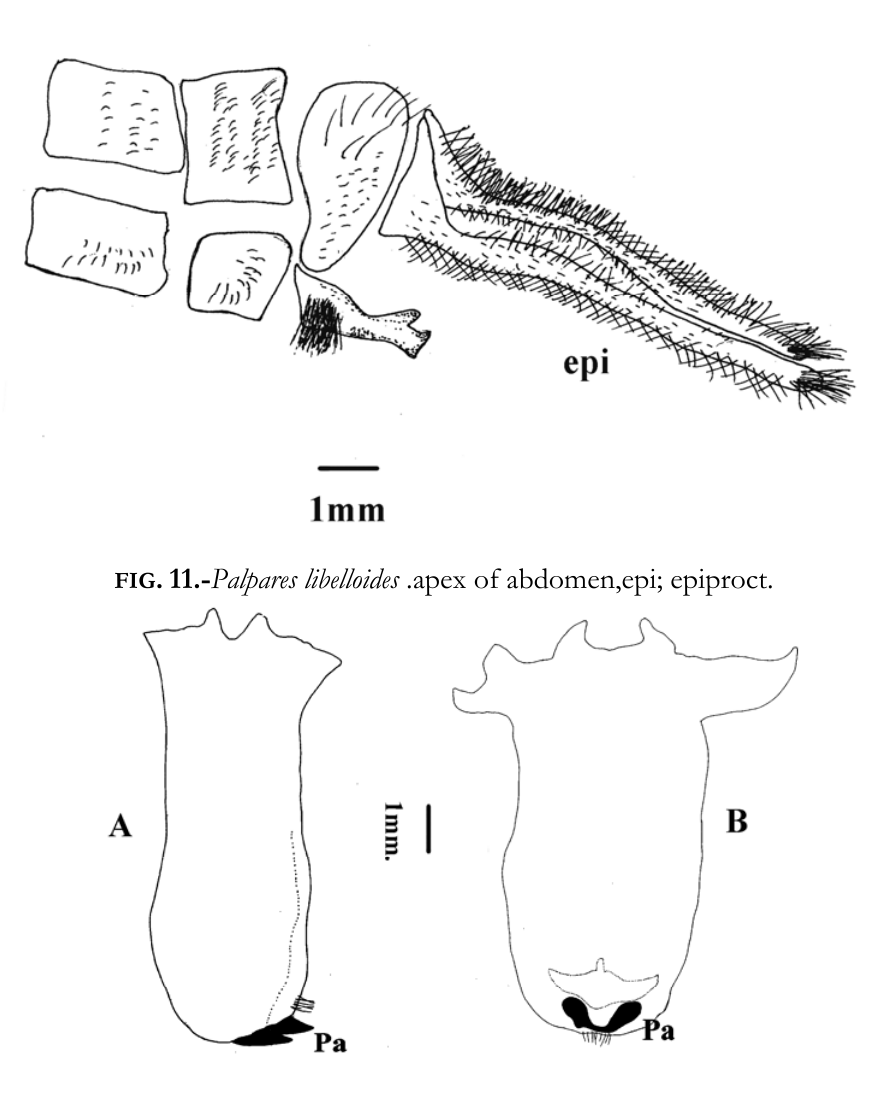
FIG . 12.- Palpares libelloides .Male genitalia .A; lateral view, B; ventral view,Pa ;